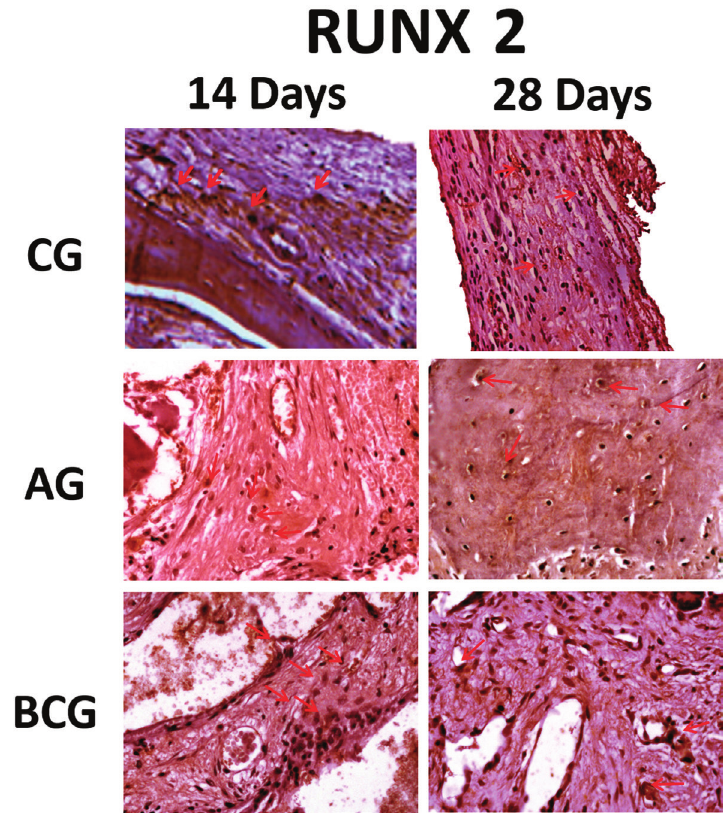
Figure 6- RUNX-2 immunostaining at 14 days for the experimental groups (CG: light; AG: moderate; BCG: moderate) and at 28 days (CG: light; AG: moderate; BCG: light). Immunolabeling indicated by red arrows